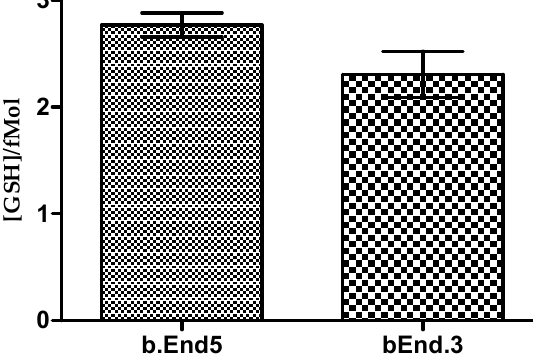
Figure 3. A comparison of GSH concentration in the two types of cells revealed no statistical difference between the two means (Student ′ s t test: p =